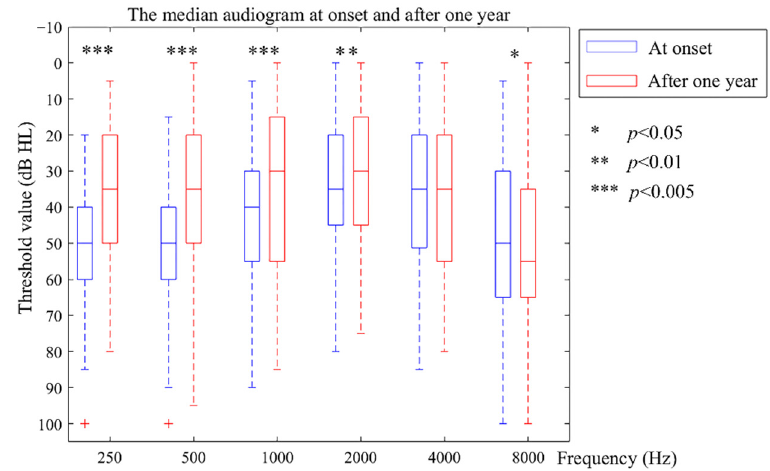
Figure 1. The medium audiogram at onset and after one year. Table 3. The comparison between different hearing results of the patients after clinical